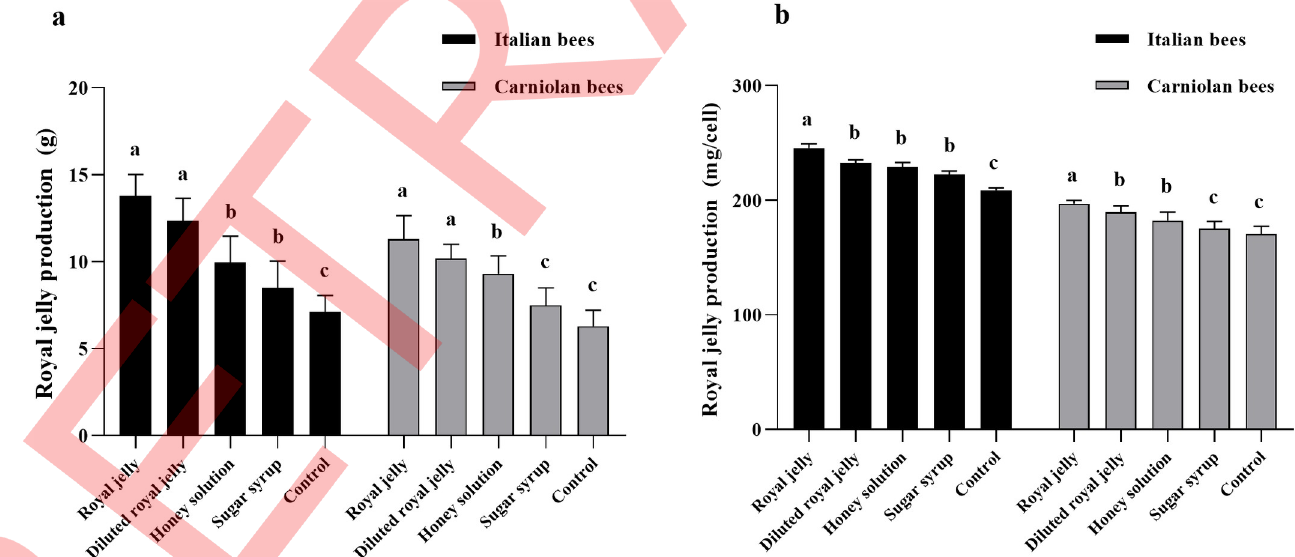
Fig 4. The effect of various priming media on royal jelly (mean ± SE) production of Italian and Carniolan colonies. (a) RJ production per colonies in grams after 72 hours of harvesting, (b) RJ production per cell cup in (mg) between both bee stocks. “ a, b, c ” different letter represents significant mean differences (Student’s t -test, p <